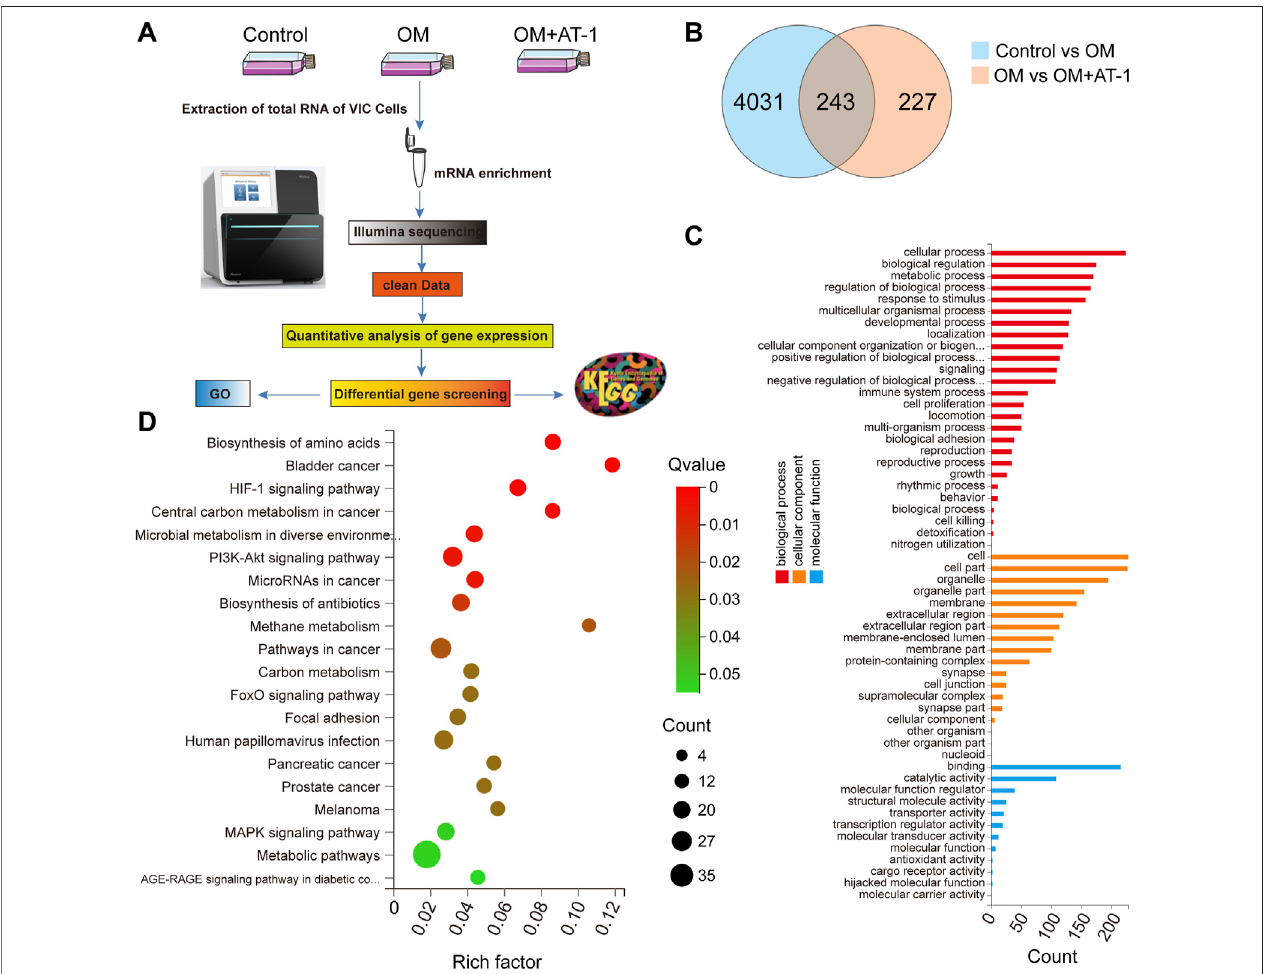
FIGURE 3 | Changes in gene expression under different treatments analyzed by mRNA-seq. (A) Schematic diagram of the mRNA transcriptome sequencing process. (B) Venn interaction of DEGs of the Control versus the OM group, and the OM group versus the OM + AT-1 group. (C) GO enrichment of the commonly detected DEGs, which included molecular function, cellular components, and biological processes. (D) KEGG pathway enrichment bubble map, where a larger p -value (-log10) indicates a higher degree of enrichment.